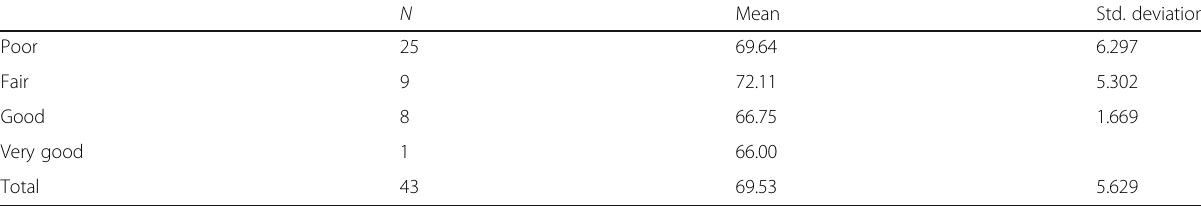
Table 3 Interpretation of V-QOL among the elderly with voice complaints N Mean Std.